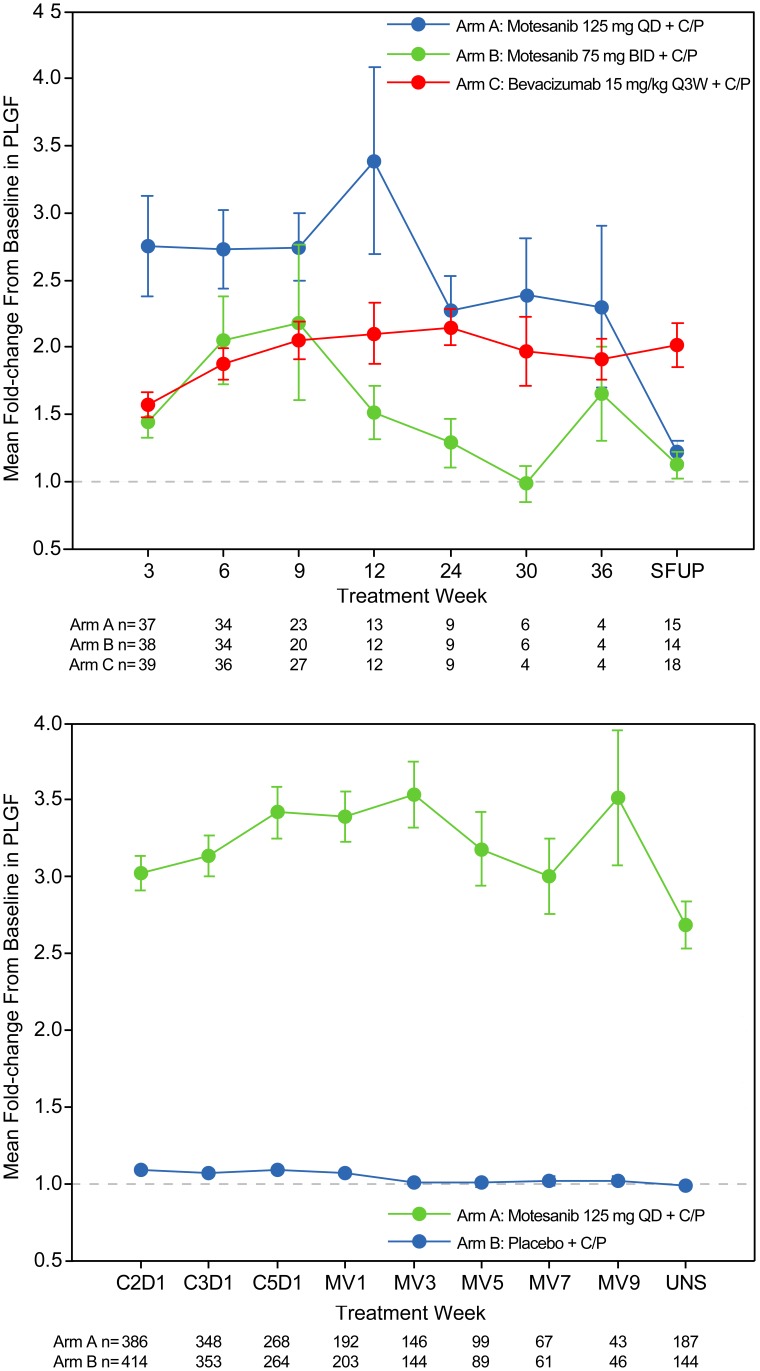
Pharmacodynamic changes in placental growth factor (PLGF).Mean fold-change (±SE) from baseline in serum PLGF over time in response to treatment with motesanib during the phase 2 study (A) and the phase 3 Motesanib NSCLC Efficacy and Tolerability study (B). BID = twice daily; C = cycle; D = day; MV = maintenance visit; Q3W = once every 3 weeks; QD = once daily; SFUP = safety follow-up; UNS = unscheduled.